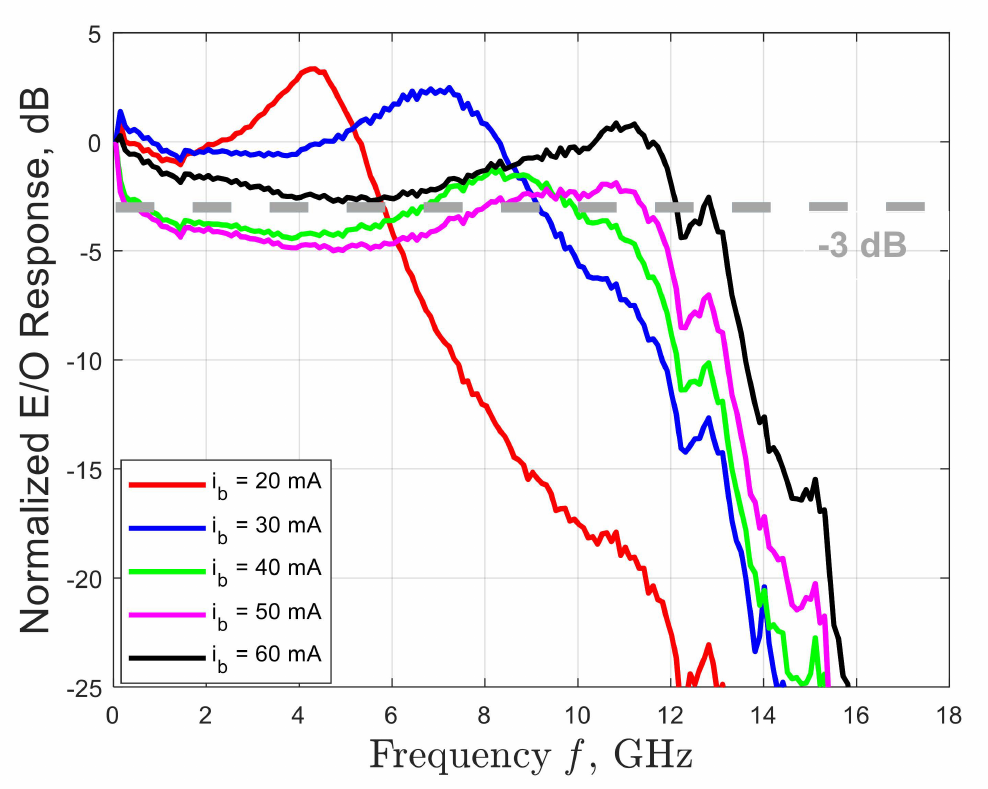
Figure 2. Measured E/O response of the 10G-class DML with different bias currents of the DML i b in C-band (1550